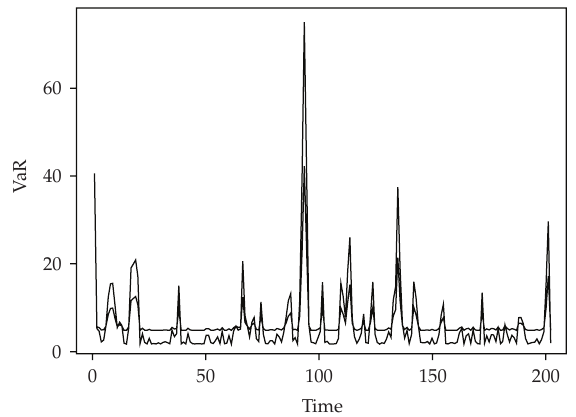
Figure 6: True and ARCH-Based VaR (cid:2) 800 obs (cid:3) .